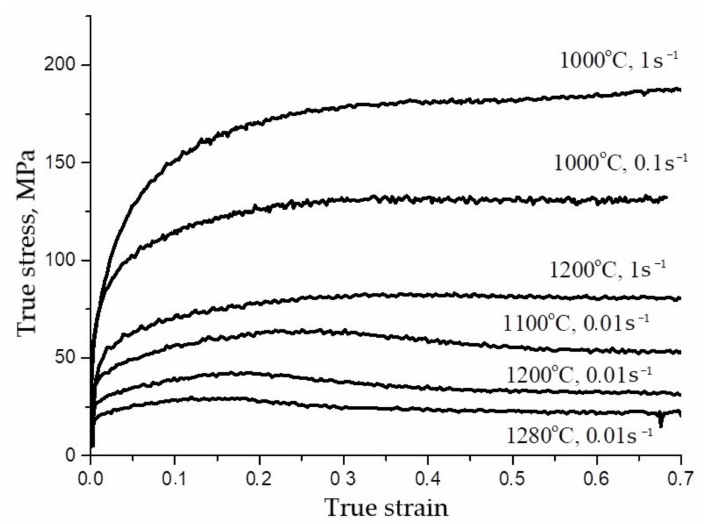
Figure 1. True stress-true strain cures of AISI 321 steel. The temperature and strain rate are shown in the